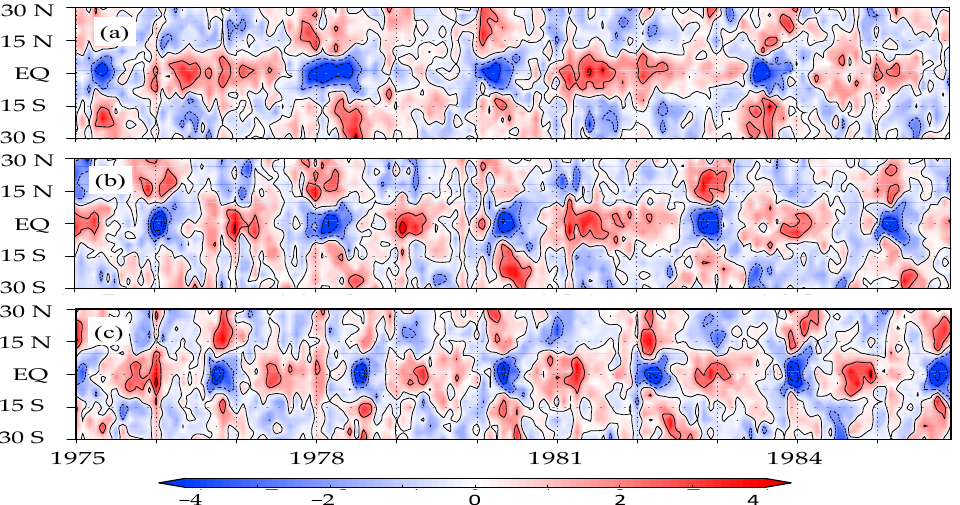
Figure 9. Time-latitude cross-sections of residual mean vertical velocity anomalies at 20 hPa for the ( a ) P, ( b ) ST, and ( c ) N runs from 1975 to 1985. Units of the color bar scale and the contours interval are 2 × 10 − 4 ms − 1 . Figure 10 exhibits the time–latitude cross-sections of residual mean meridional velocity anomalies v ∗ between 30 ◦ S and 30 ◦ N at 20 hPa from 1975 to 1985. The meridional width of v ∗ is estimated about 50 ◦ between 25 ◦ S and 25 ◦ N, slightly wider than that of zonal wind, though its zero-wind latitudes are not necessarily determined. The temporal–spatial pattern of v ∗ shows quadruple finer structures in the three runs during the phase reversal of zonal-wind. This fine structure is based on the temporal and spatial features that v ∗ temporally reverts its direction in the vicinity of the phase reversal of zonal-wind, and v ∗ is spatially antisymmetric with respect to the